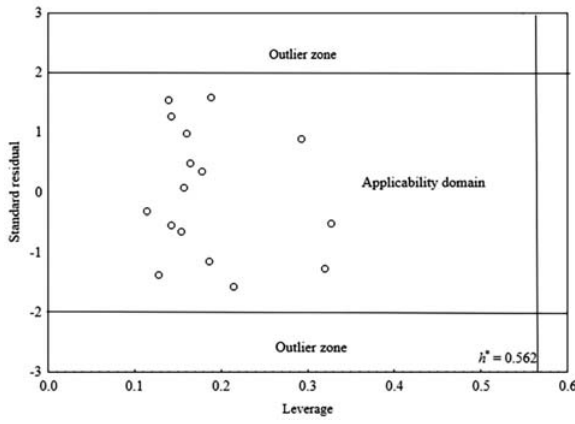
Fig. 2. Applicability domain of the QSAR model for% inh. calcula- ted by model III.QSAR models